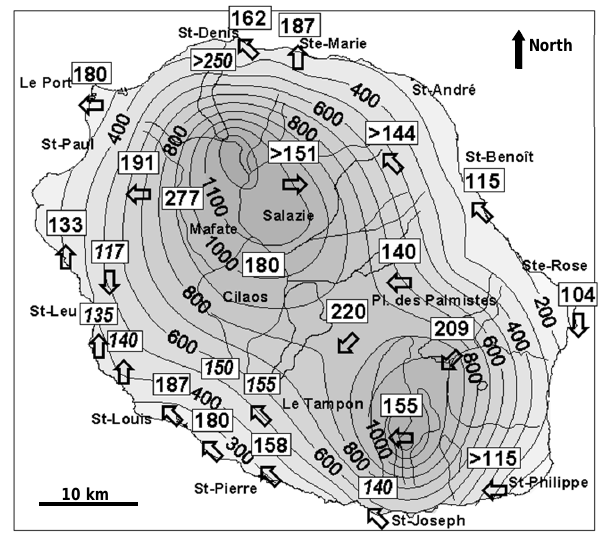
Fig. 2. Accumulated rainfall (shaded contours, mm) and wind di- rection (arrows) for wind maxima (kmh − 1 ) observed in R´eunion island from 00:00UTC on 22 January 2002 to 00:00UTC on 23 January 2002 (adapted with permission from RSMC La